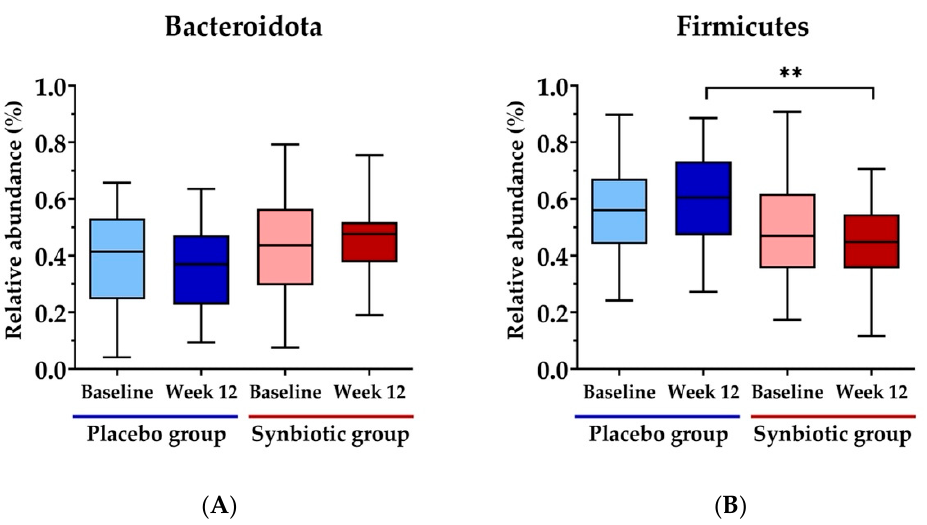
Figure 3. Percent relative abundance of dominant phylum across second treatment groups. ( A ) Phylum Bacteroidota , ( B ) phylum Firmicutes . Values are represented as mean ± SD. ** p < 0.01 compared to placebo at week 12 .